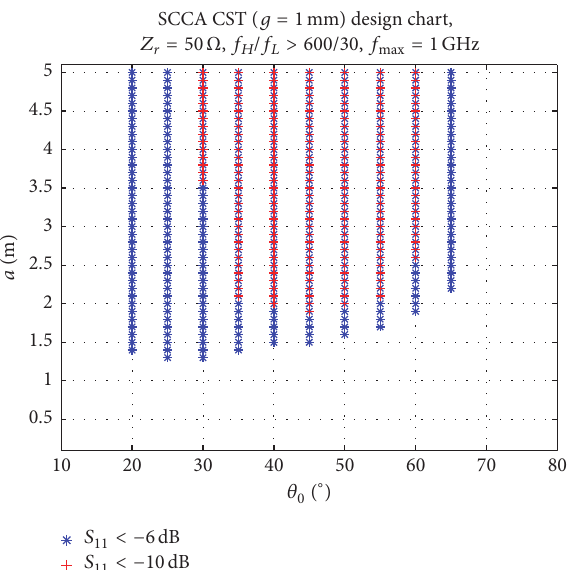
Figure 21: 𝑍 of the OCA for 3 different gap lengths and 𝜃 0 = 15 ∘ in ( 𝑅 : curves above, 𝑋 : curves in in